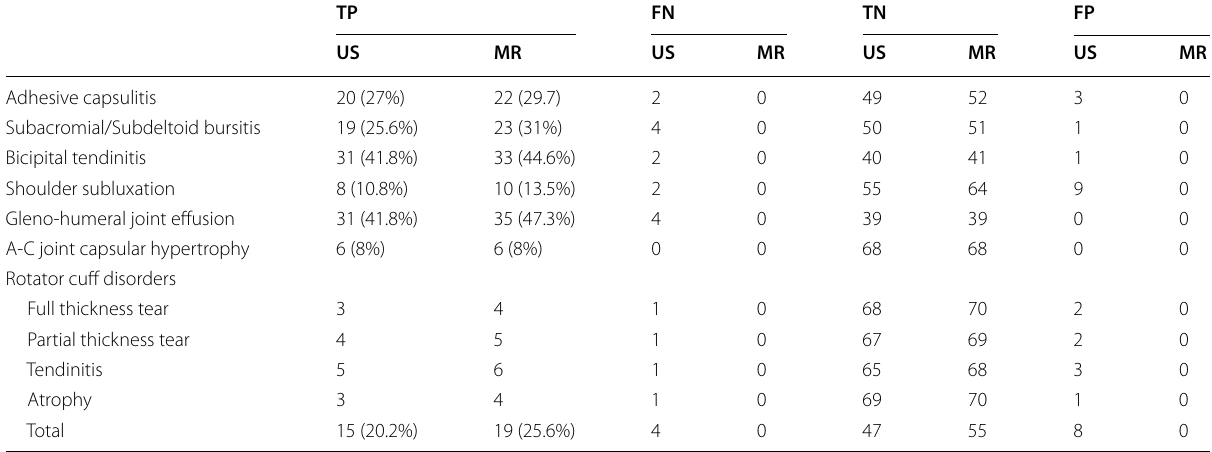
TP true positive; FN false negative; TN true negative; FP false positive; A-C